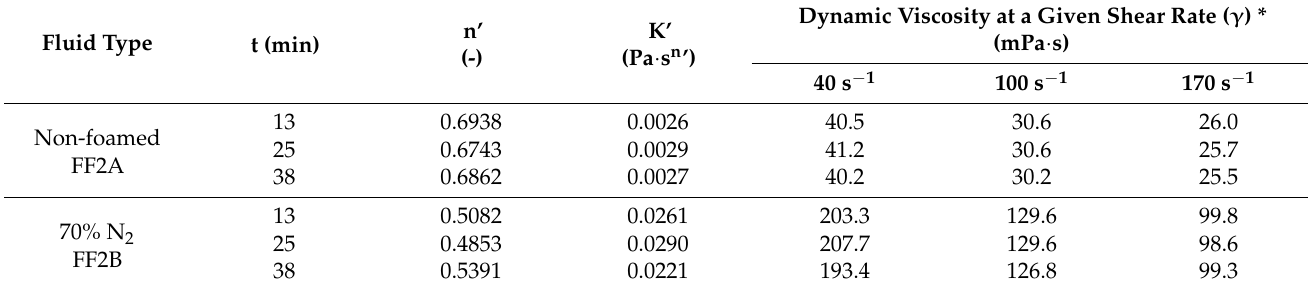
Table 5. Rheological parameters of non-foamed fluids (FF2A) and fluids energized with N 2, foam quality of 70% (FF2B) at 60 ◦ C.